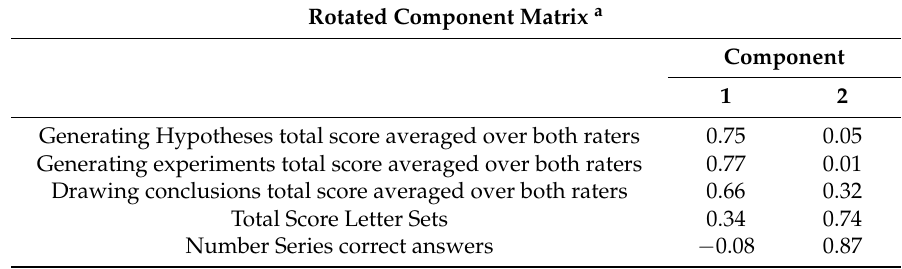
Table 11. Principal component analyses in Study 2 without new scales with analytical ability tests.